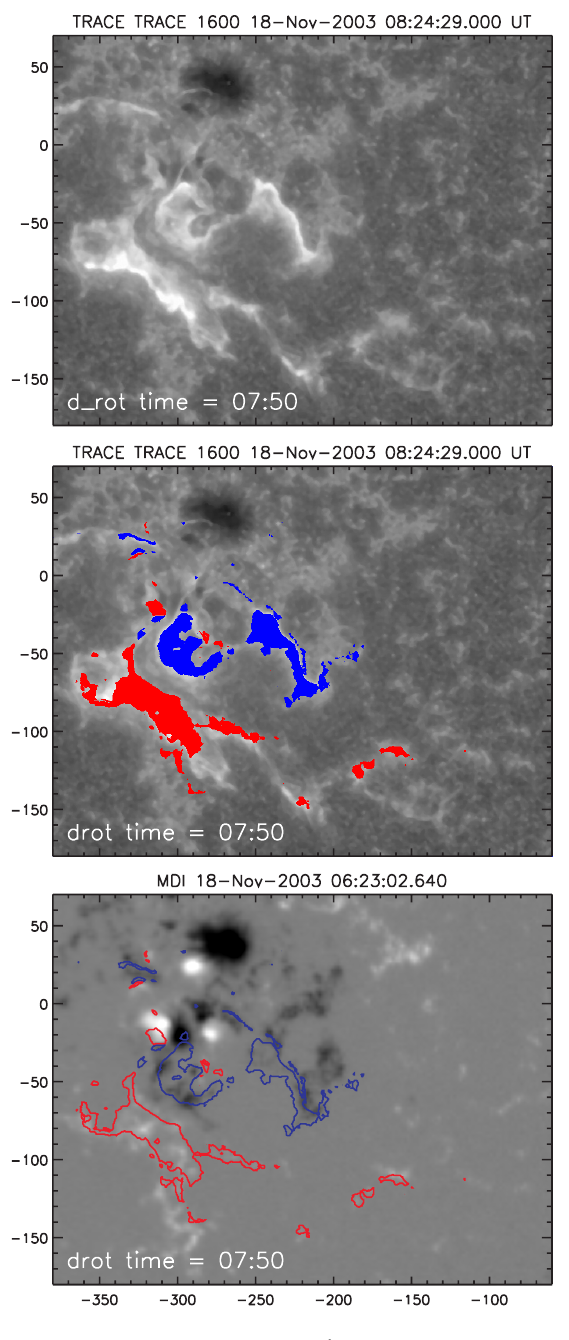
Fig. 6. Upper panel: TRACE 1600 ˚A flare ribbons near the end of the impulsive phase. Middle panel: Blue/red pixels mark all TRACE pixels that brightened during any period of the analyzed time interval of the flare, where blue areas refer to negative and red areas to positive magnetic polarities of the underlying photospheric magnetic field. Bottom panel: Contours of the total flare area super- posed on a MDI magnetogram, where white/black patches represent the positive/negative magnetic polarity domains.